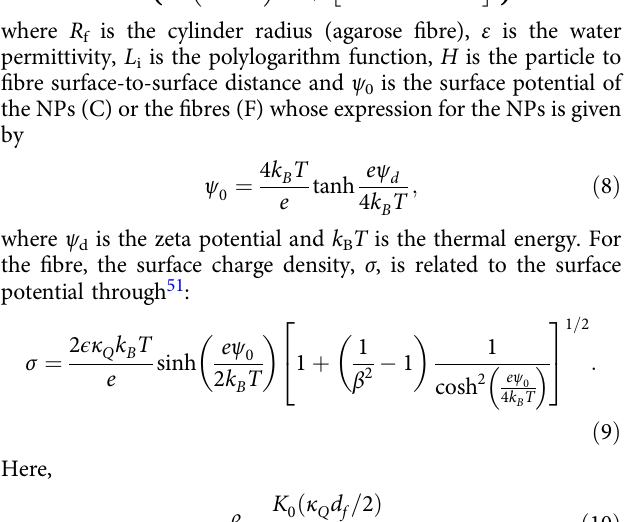
¼ (cid:2) 4 ϵ V R